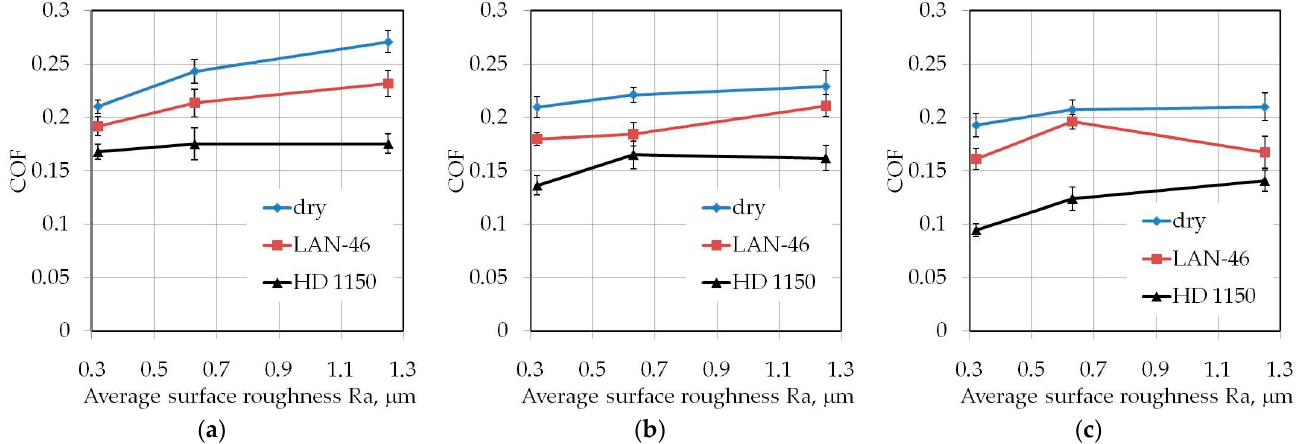
Figure 12. Effect of countersample roughness on the value of COF for specimens with a width of w = 20 mm cut along the rolling direction (orientation 0°): ( a ) h = 6 mm, ( b ) h = 12 mm, ( c ) h = 18 mm.